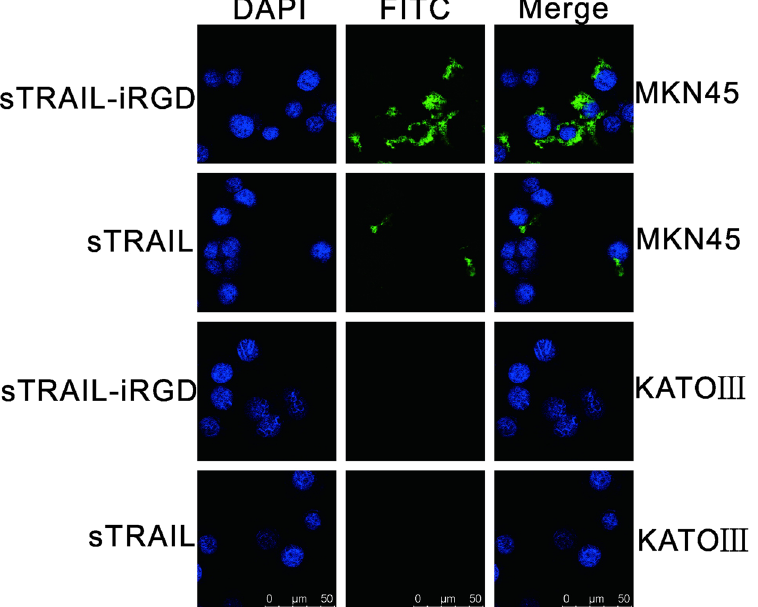
Figure 2. sTRAIL-iRGD and sTRAIL internalization into MKN45 and KATOIII cells. MKN45 cells, which are positive for NRP-1 and DR4, and NRP-1-deficient, DR4-deficient KATOIII cells were incubated with FITC- labeled fusion proteins. Nuclei were stained with DAPI (blue). Proteins were visualized by confocal